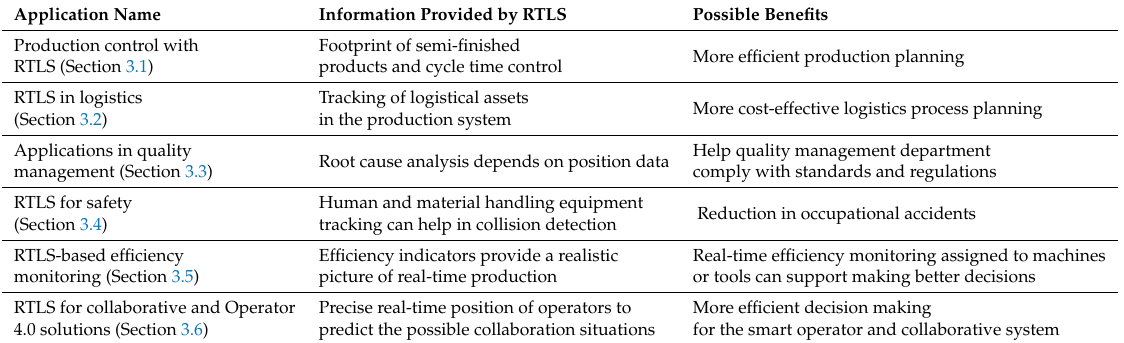
Table 4. Application of RTLS in manufacturing, the useful information it provides and possible